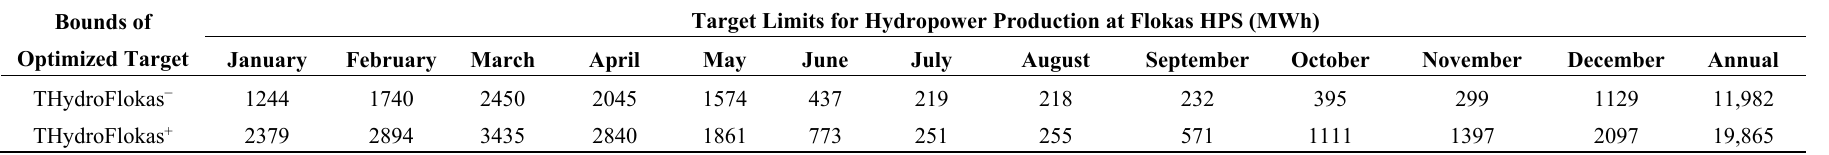
Table 3. Upper- (THydroFlokas + ) and lower- (THydroFlokas − ) bounds of optimized target for hydropower production at HPS at Flokas. Bounds of Optimized